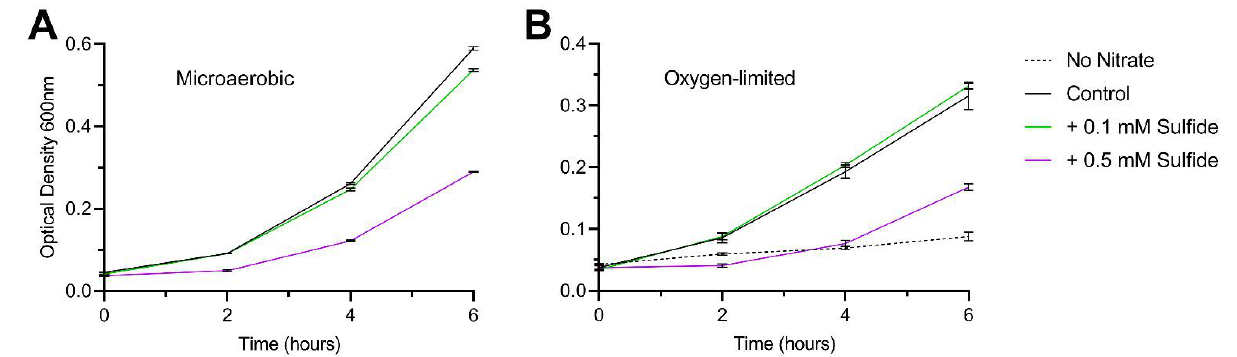
Figure 8. Growth inhibition of C. jejuni in complex media by sulfide. Cells were grown in Muller- Hinton broth supplemented with 20 mM L-Serine and 10 mM sodium nitrate, under either ( A ) mi- croaerobic or ( B ) oxygen-limited conditions. Sulfide was added by bolus addition at the beginning of the growth curve at either 0.1 or 0.5 mM final. No sulfide controls were included in both conditions, and a nitrate minus control included under oxygen-limited conditions to confirm nitrate dependent growth and oxygen limitation.